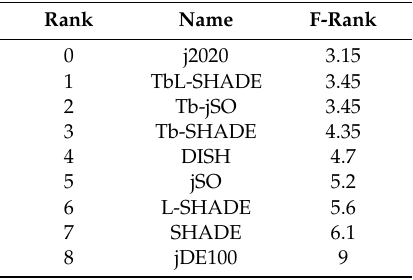
Table 37. The Friedman ranks of comparative algorithms on CEC2020 in 15 D .